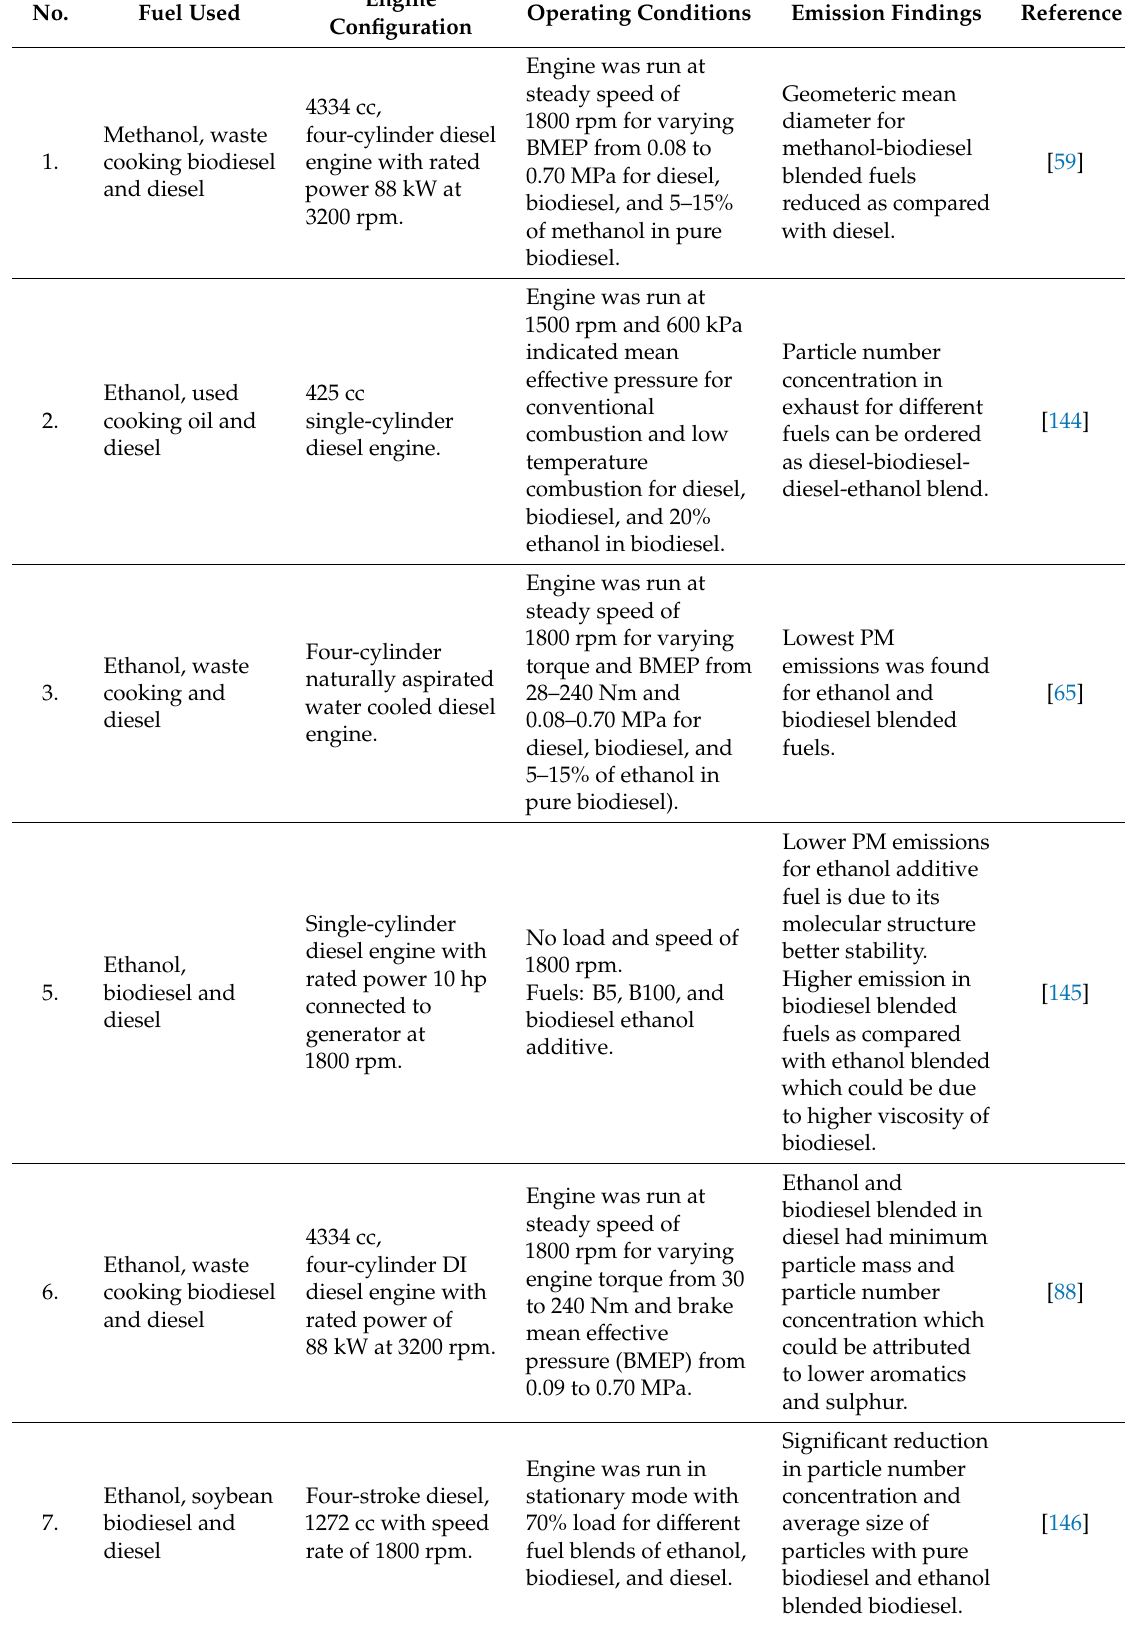
Table 2. Literature summary of observations made for di ff erent alcohol